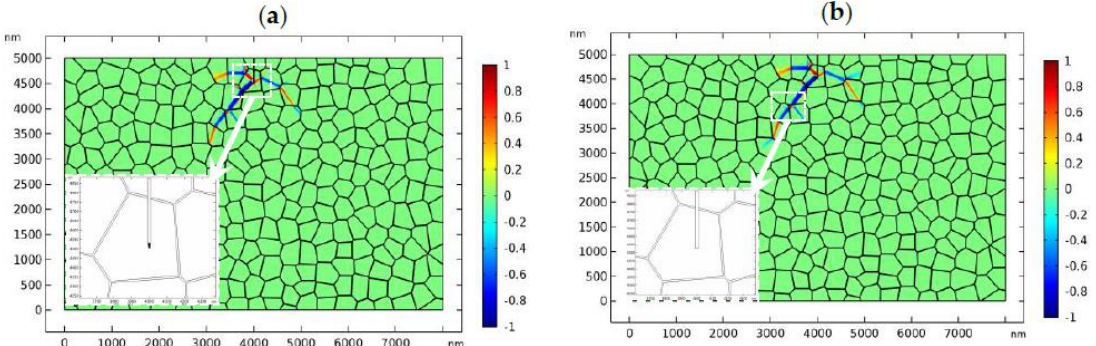
Figure 7. The evolution of the phase transformation and crack propagation in tetragonal zirconia polycrystal (TZP) (crystal orientation I) where the applied load is 110 MPa ( a , b ) at times 0.4 μs and 2 μs ,